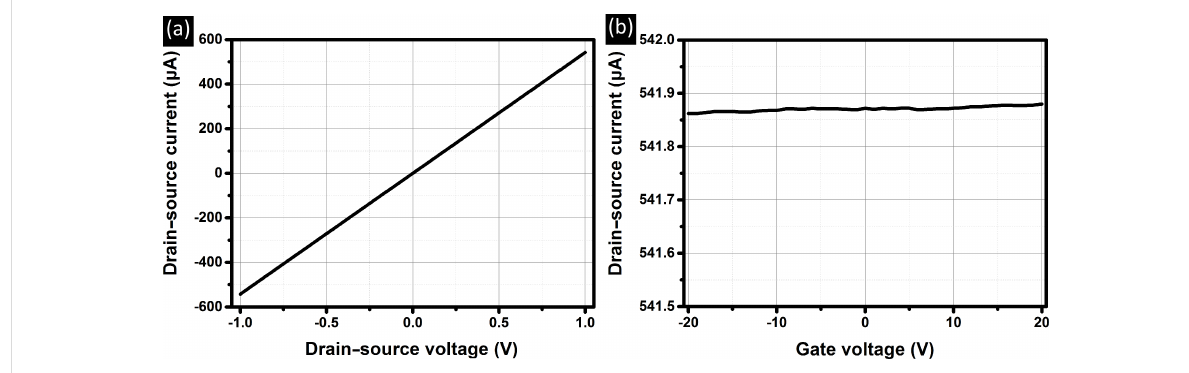
Figure 5: Drain–source currents measured versus the (a) drain–source and the (b) gate-voltage for a 10 nm MoS 2 film deposited at RT. Data were obtained by utilizing the stripe contacts.